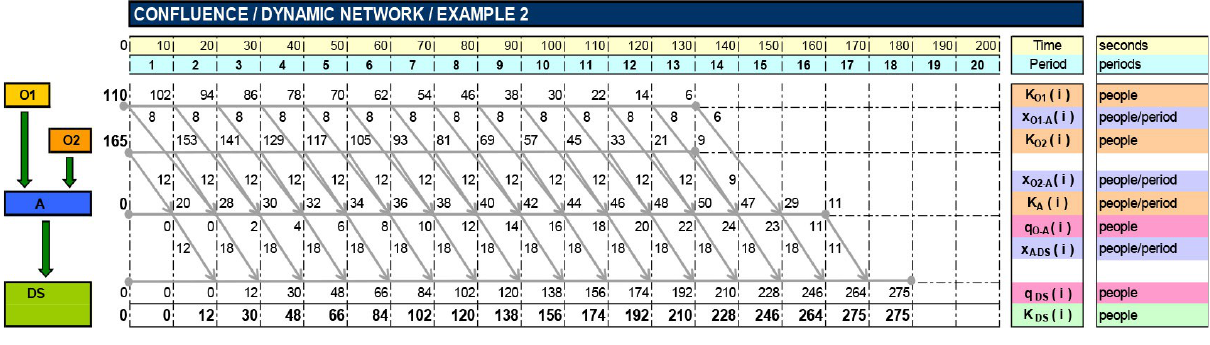
Figure 17. Example of a confluence dynamic network